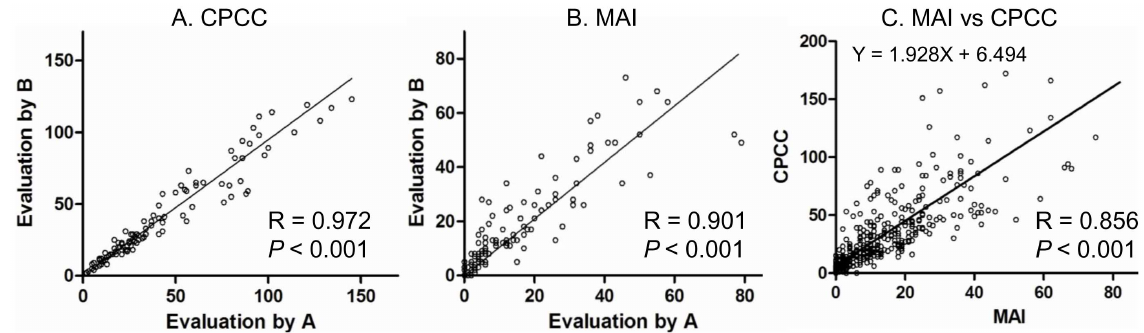
Figure 2. Inter-observer correlations of CPCC or MAI and correlation between CPCC and MAI. A. Inter-observer correlation of CPCC among 100 cases. B. Inter-observer correlation of MAI among 100 cases. C. Correlation between CPCC and MAI in total 375 cases. Two data points are outside the axis limits in C. The slope and Y intercept are shown. The correlations were calculated by two-sided Spearman test. CPCC = chromatin CKAP2-positive cell count; MAI = mitotic activity index.